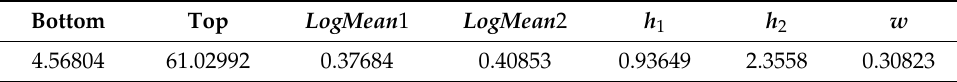
Table 2. Candidate models.